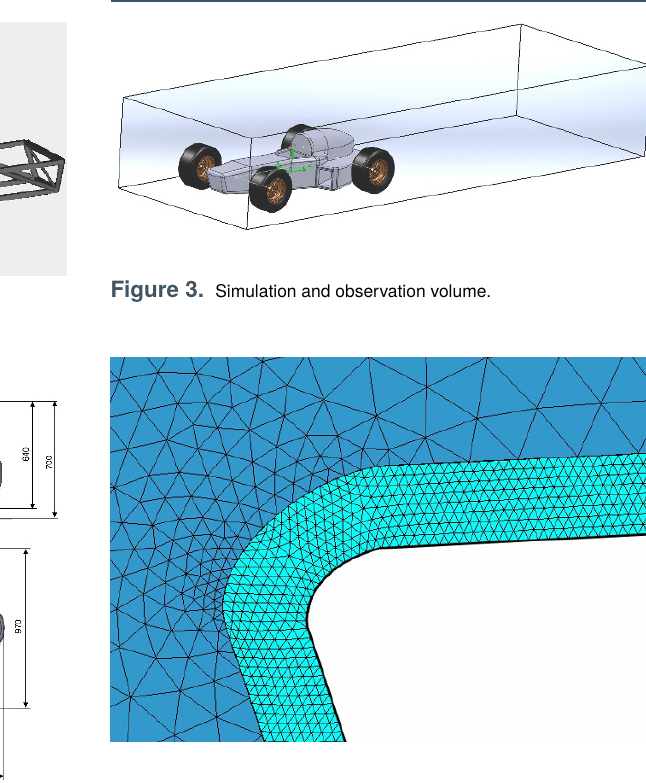
Figure 2. TU Cluj-Napoca Formula SAE Student prototype.